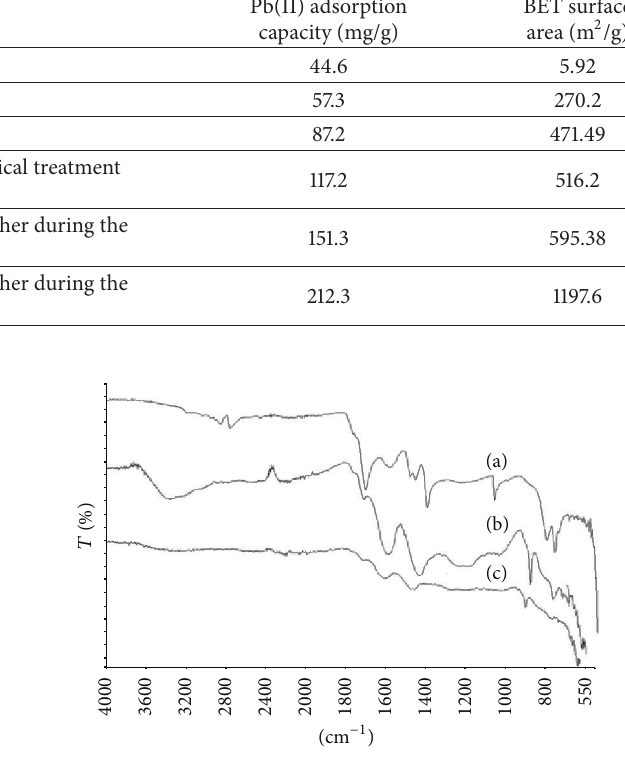
Figure 6: Spectra of (a) the physicochemically treated AC with only microwave application followed by pyrolysis at 250 ∘ C, (b) the physicochemically treated AC with microwave and ultrasound applications together followed by pyrolysis at 250 ∘ C, and (c) the Pb(II)-loaded